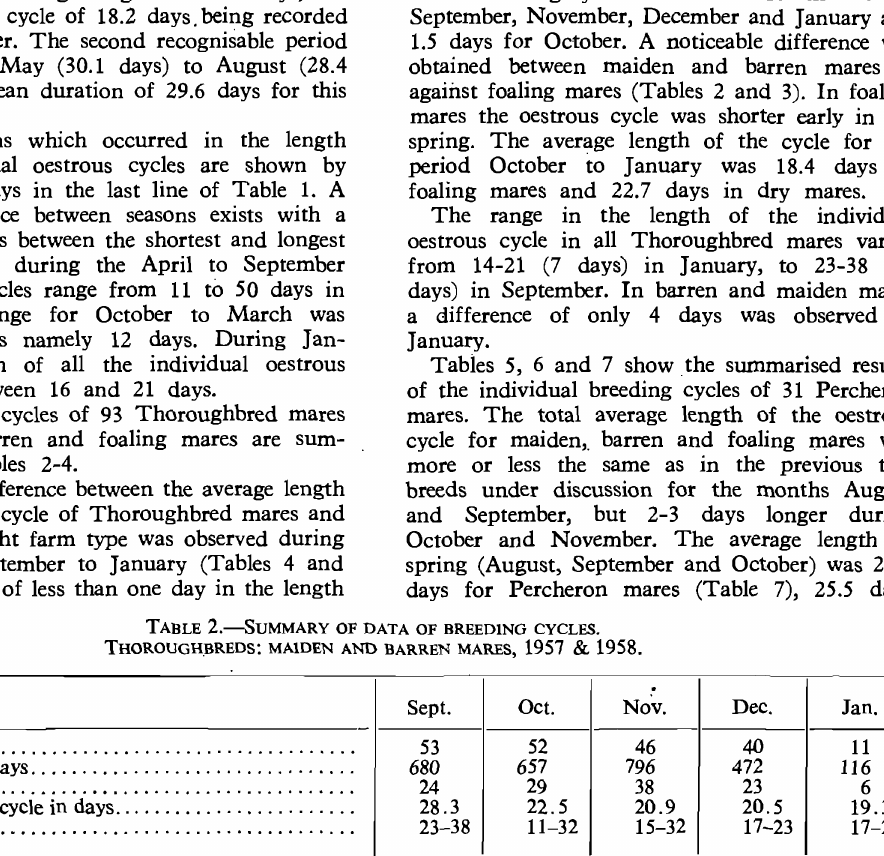
TABLE 3.-SUMMARY OF DATA OF BREEDING CYCLES. THOROUGHBREDS: FOALING MARES, 1957 & 1958.